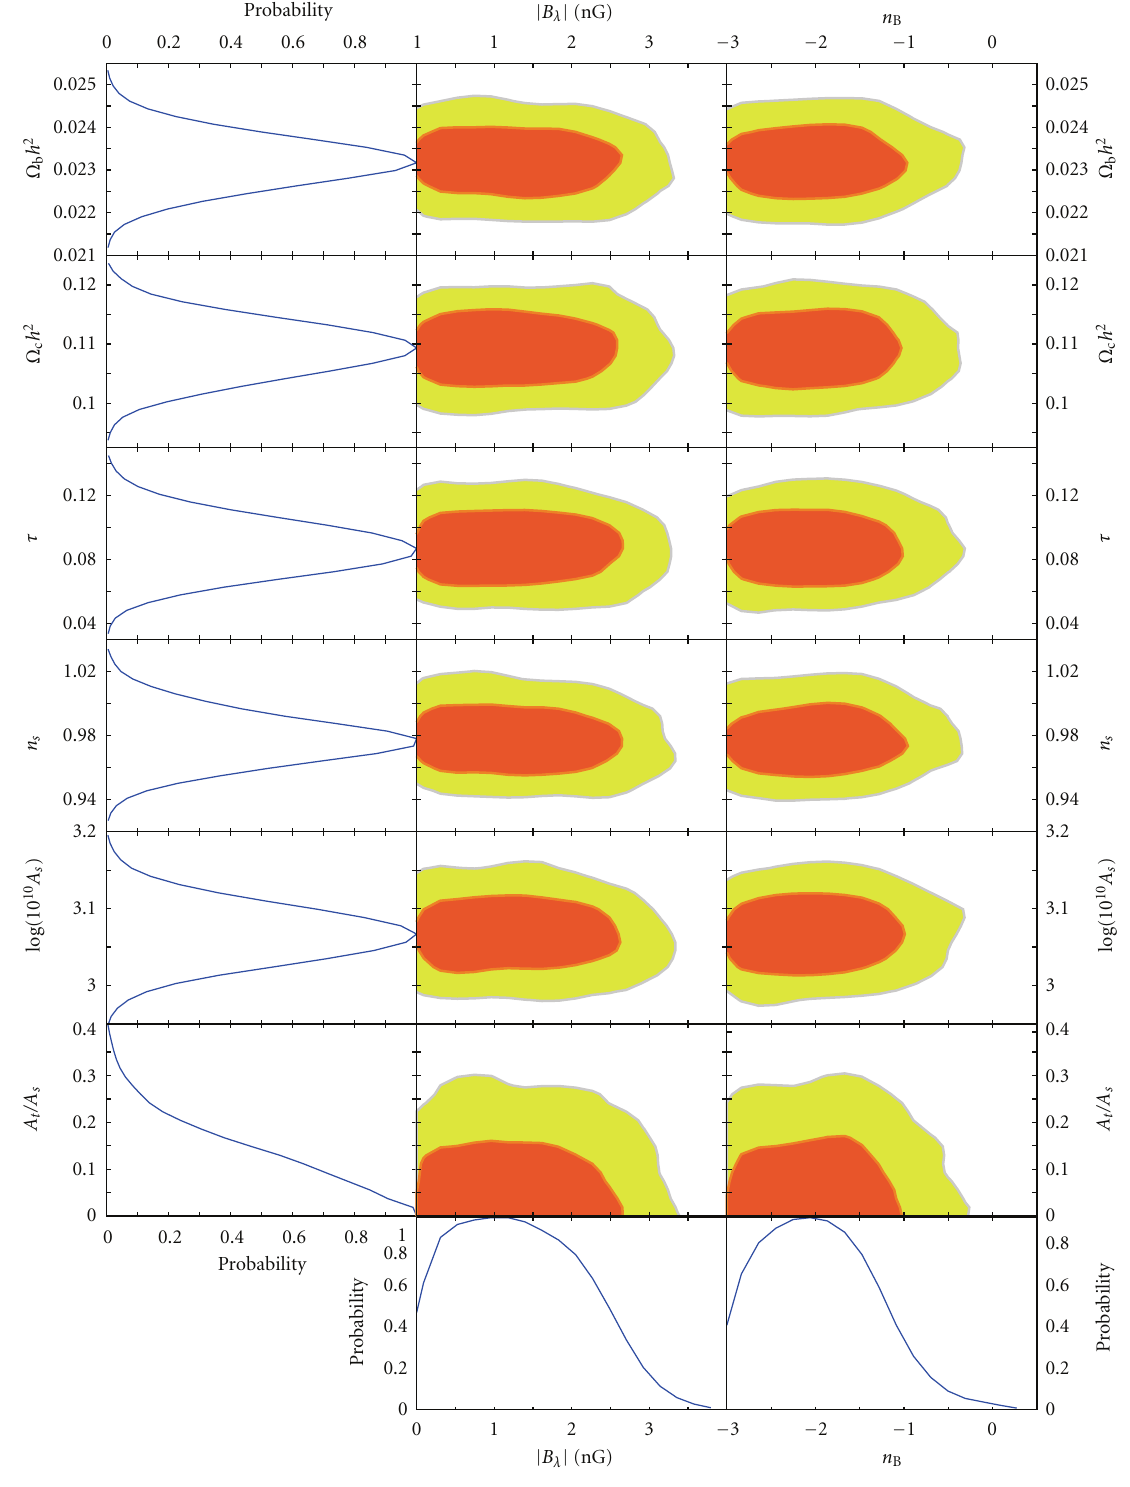
Figure 9: Probability distributions and contours of 1 σ and 2 σ confidence limits for the standard cosmological parameters as a function of the PMF field strength | B λ | and power law index n B . Orange contours show 1 σ (68%) confidence limits, and yellow contours show 2 σ (95%) confidence limits. Blue curves in the left and bottom of the figure show the probability distributions of each parameter. Note the existence of a maximum in the probability distributions for | B λ | and n B . The standard cosmological parameters do not have a degeneracy with the PMF parameters because they are mainly constrained by the observed CMB data for (cid:11) < 1000 (up to the 2nd peak), while the PMF is mainly influenced by the power on smaller angular scales and higher multipoles, (cid:11) >